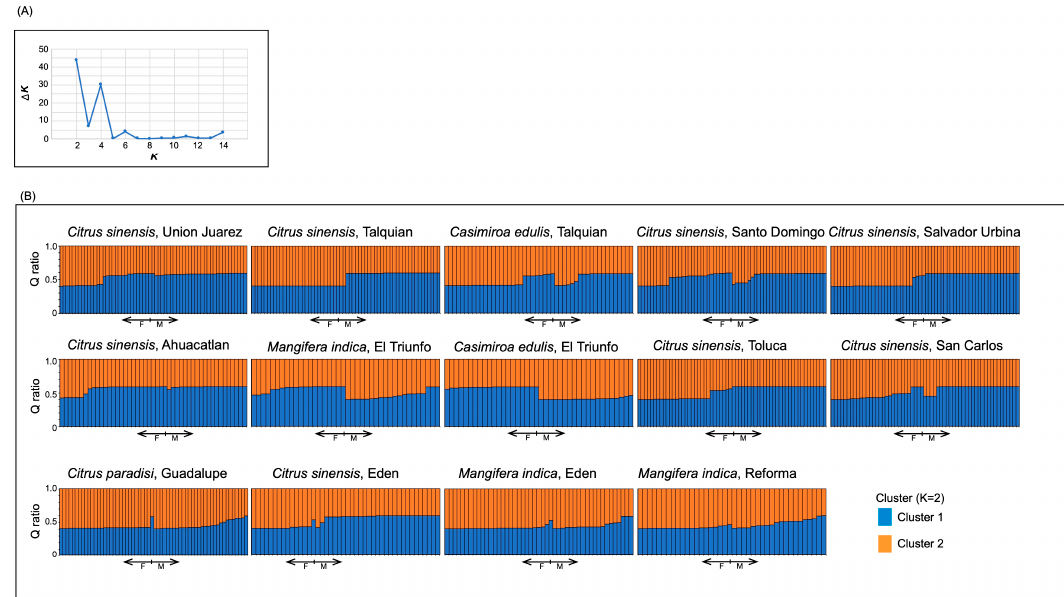
Figure 2. ( A ) ∆ K calculated following the methods of Evanno et al. [43] and ( B ) Bayesian grouping of samples of A. ludens in the Soconusco region based on the Q (membership coefficient matrix) ratio of identified genetic groups. Each bar represents an individual, female (F) or male (M) as indicated, and each color represents the proportion of each genetic cluster. The top label indicates the host and locality of the collection.